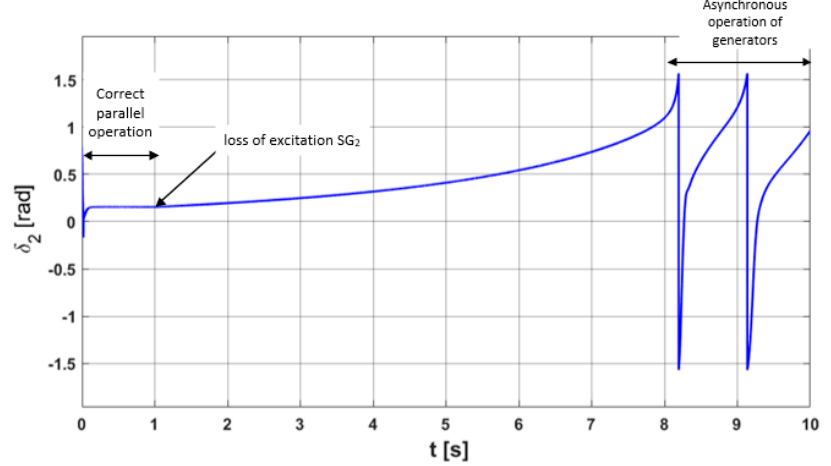
Figure 11. The waveform of the load angle δ 2 with the loss of excitation for SG 2 .